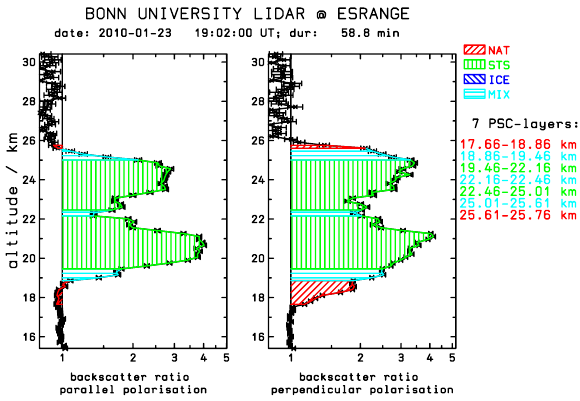
Fig. 7. Backscatter ratio in parallel (left) and perpendicular (right) polarisation measured with the Esrange lidar, 1-h integration time, Fig.7. Backscatterratioinparallel(left)andperpendicular (right)polarisationmeasured withtheEsrangelidar, starting at 19:02UT on 23 January 2010. The colors mark the dif- 1-h integration time, starting at 19:02UT on 23 January 2010. The colors mark the different PSC types. ferent PSC